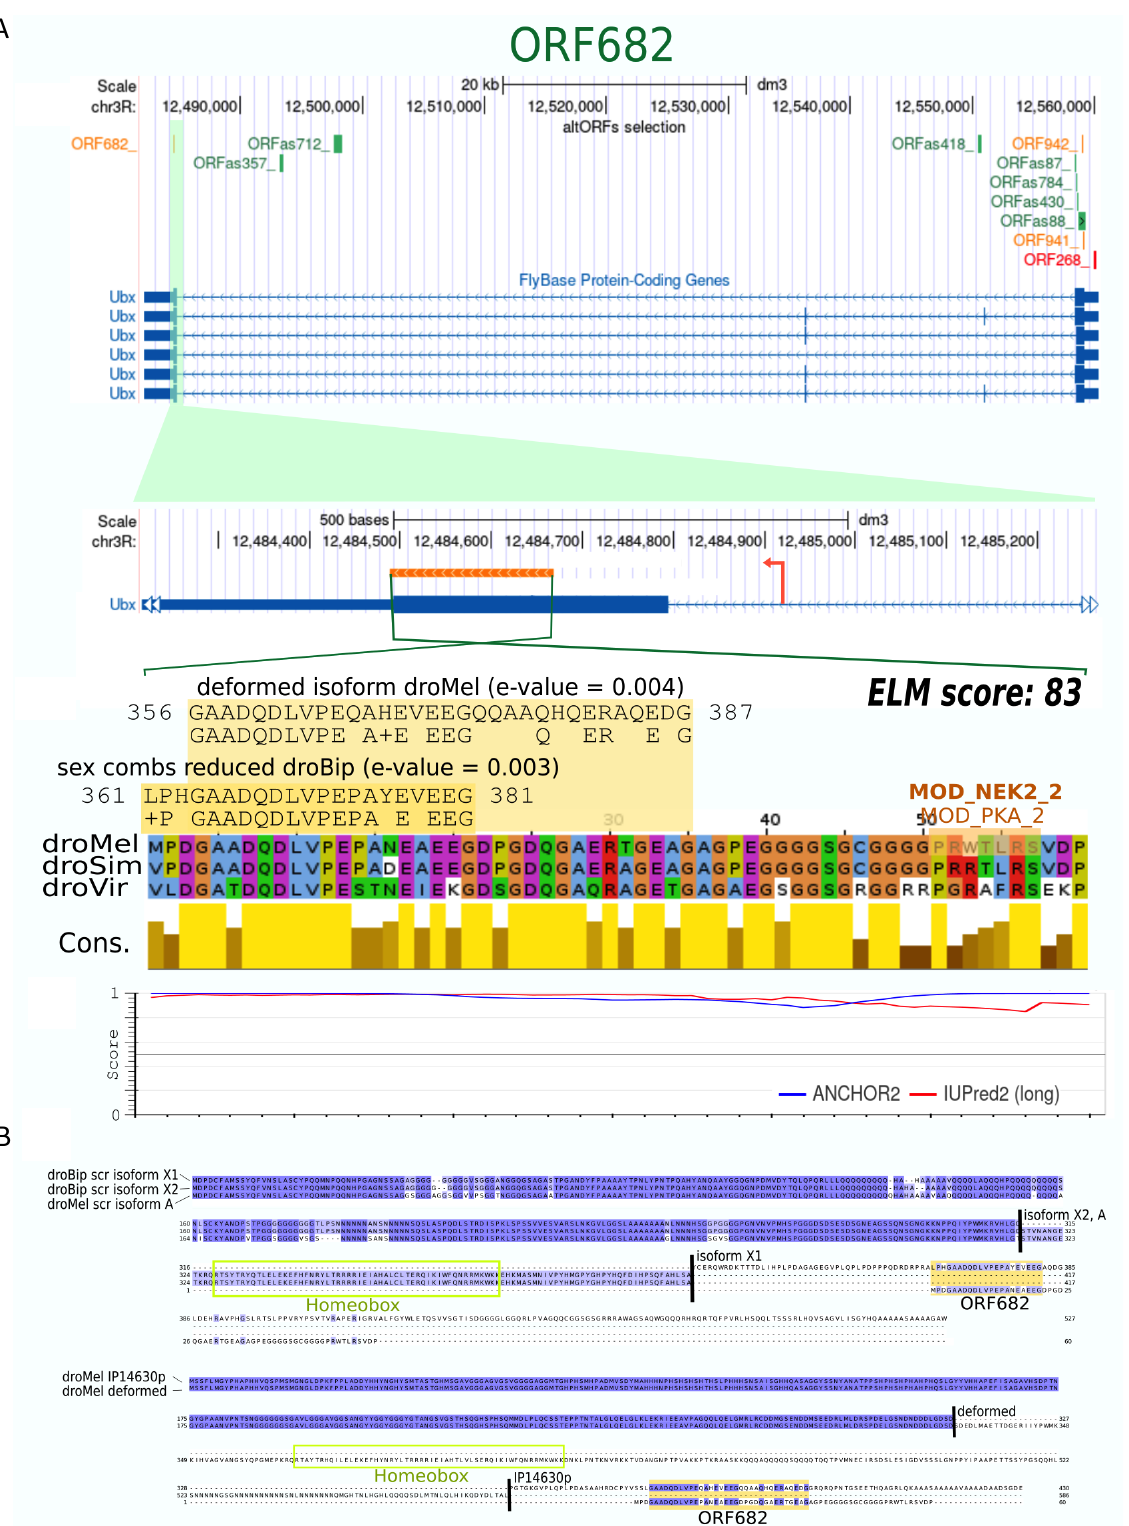
Figure 5. Characterization of the ORF682. ( A ). This altORF overlaps with the Ubx last coding exon and the beginning of its 3 (cid:48) UTR, in the same orientation but in a different reading frame. ORF682 is found in 3 Drosophila species. The 60 aas long predicted protein is globally disordered and contains only two ELMs of different type. ( B ). A peptide sequence present in the ORF682 is found in an isoform of D. bipectinata Sex comb reduced ( Scr ; isoform X1 ) and D. melanogaster Deformed ( Dfd ; isoform IP14630p ). These two isoforms result from a frameshift of the last part of the gene encoding the homeobox domain (black